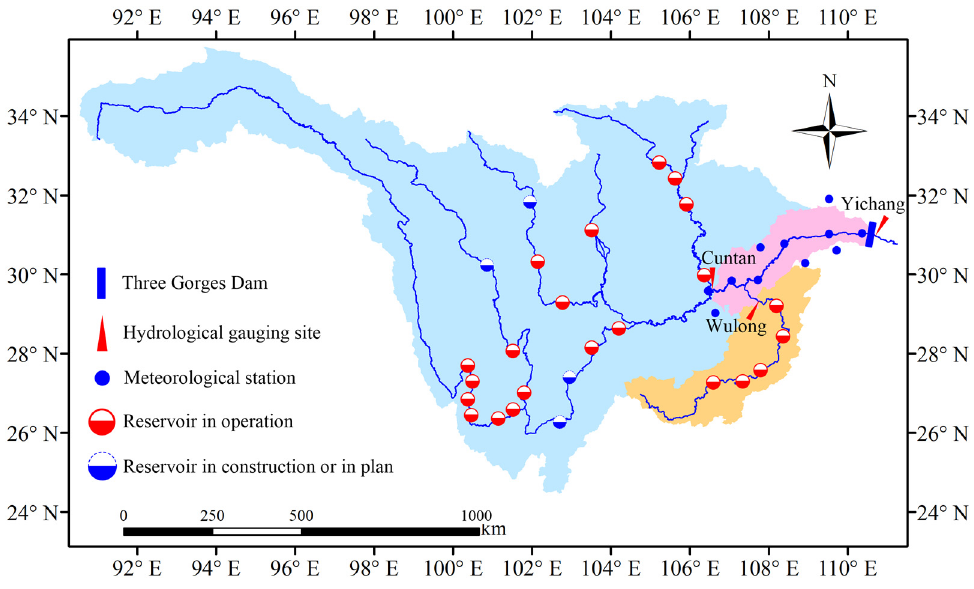
Figure 1. Map of the Upper Yangtze basin and reservoirs upstream of the Three Gorges Reservoir.